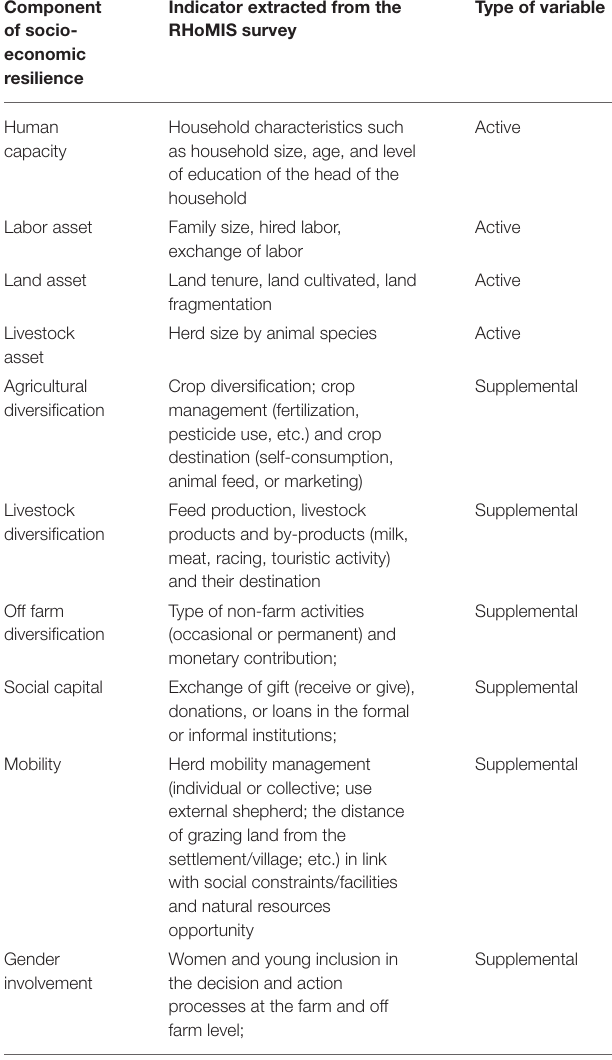
TABLE 2 | Presentation of the main socio-economic components and list of indicators to describe adaptive capacity. Component of socio- economic